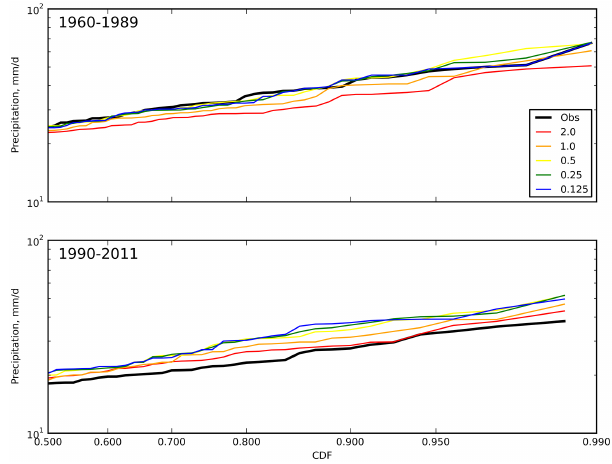
Figure 5. Similar to Fig. 4, but for the validation period for mini- mum daily temperature (upper panel) and maximum daily tempera- ture (lower